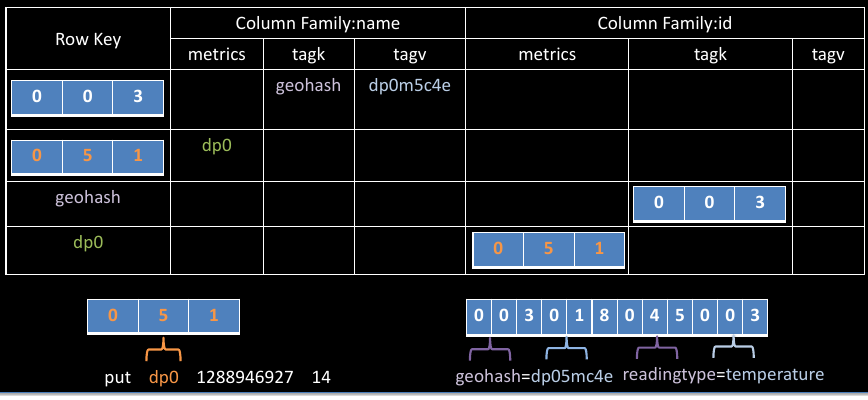
Figure 4. OpenTSDB tsdb-uid table.